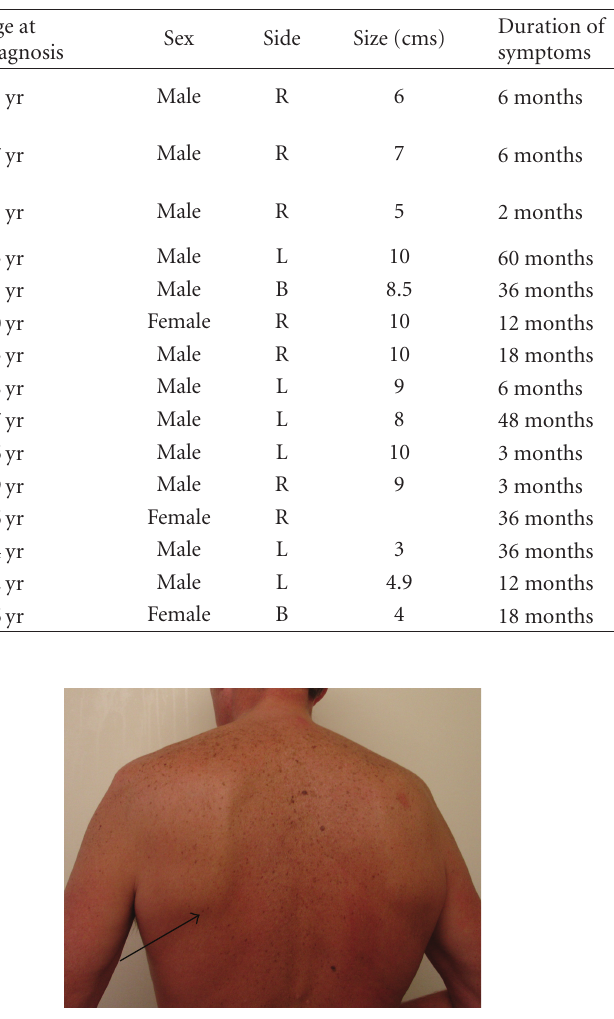
Figure 1: Arrow shows the typical location for elastofibroma dorsi.